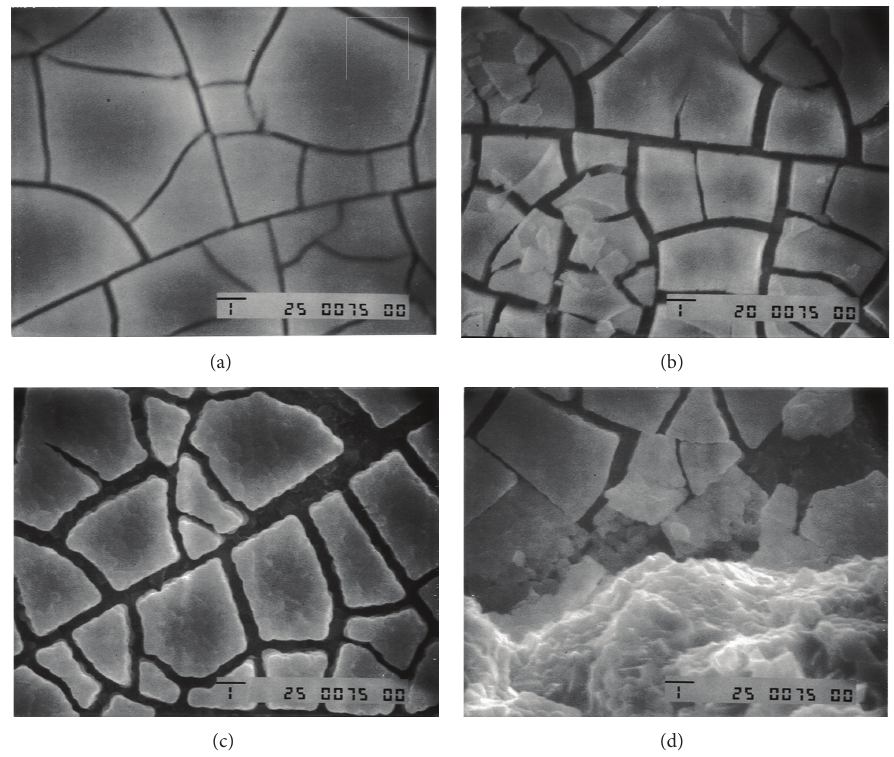
Figure 10: SEM morphologies for CeO 2 deposited with galvanostatic mode at 80 ∘ C, j = − 0.06 mA/cm 2 ; (a) unsintered: x7500; (b) sintered 500 ∘ C: x7500; (c) sintered at 900 ∘ C: x7500; (d) sintered at 1100 ∘ C: x7500.